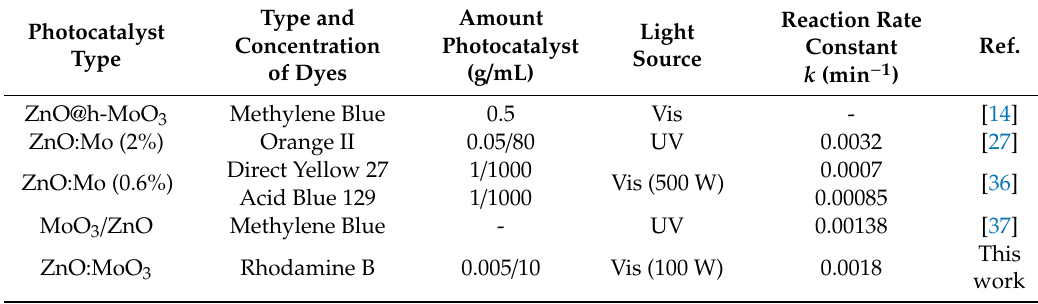
Table 4. Comparison of photocatalytic activities of ZnO:Mo